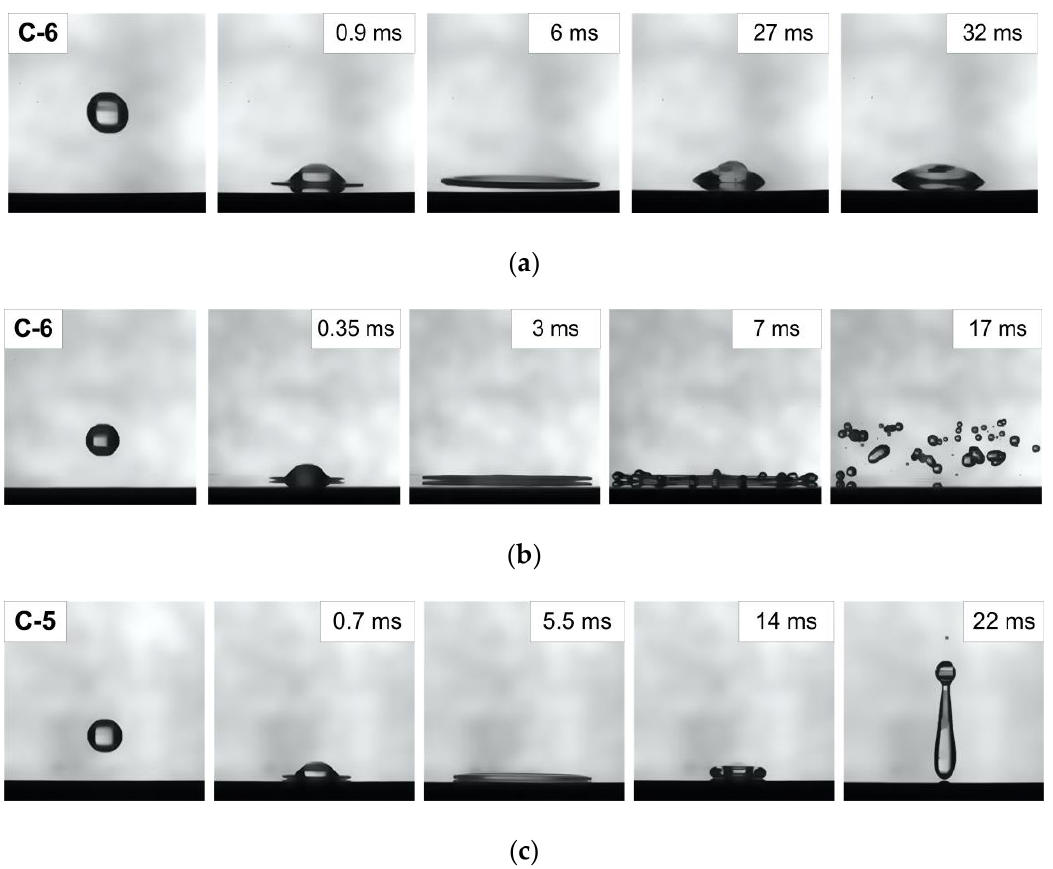
Figure 3. WiDME and WiBDME drop collision with a heated surface within different hydrodynamic regimes: ( a ) drop deposition (including drop spreading and receding), T 0 = 225 °C, D 0 ≈ 3 mm, U 0 ≈ 1.72 m/s, ( b ) drop hydrodynamic breakup, T 0 = 320 °C, D 0 ≈ 2.7 mm, U 0 ≈ 2.69 m/s, ( c ) drop rebound, T 0 = 330 °C, D 0 ≈ 3 mm, U 0 ≈ 1.72 m/s.